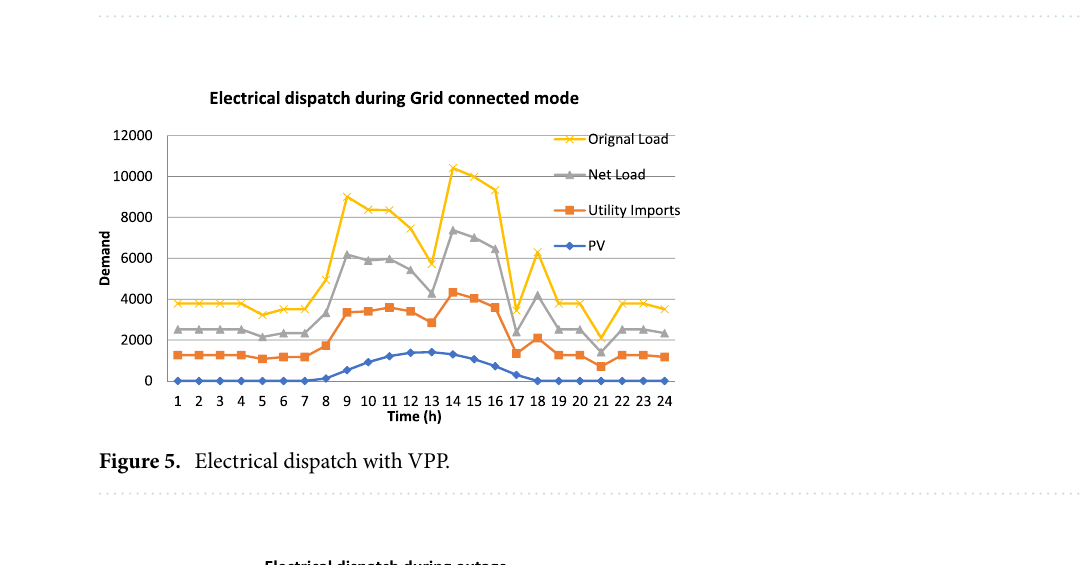
Table 7. Techno-economic analysis.